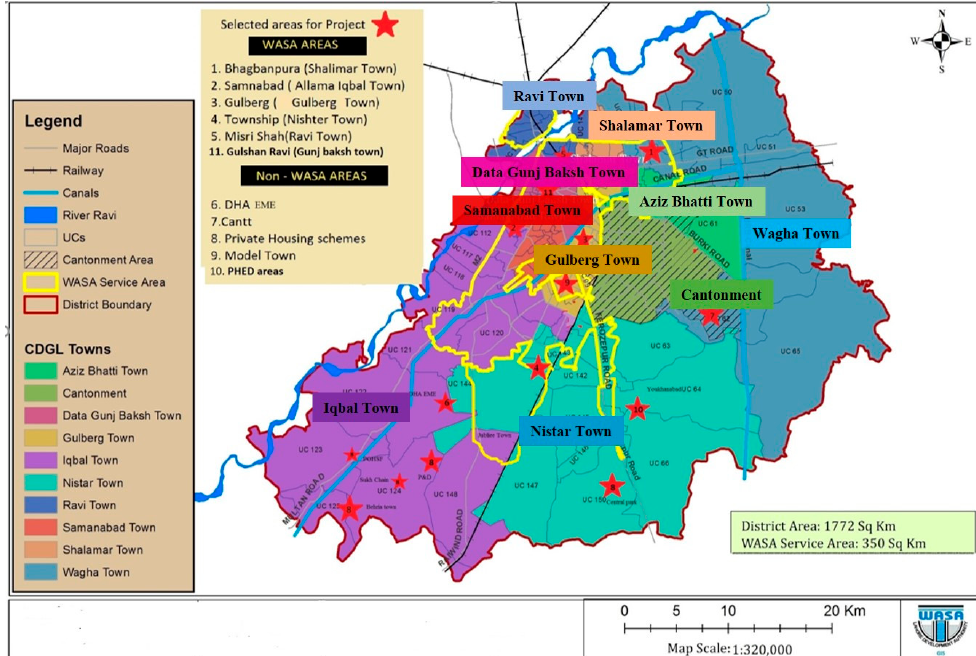
Figure 15. Location map showing sampling sites (WASA = Water and Sanitation Agency) in various towns of Lahore, Pakistan.